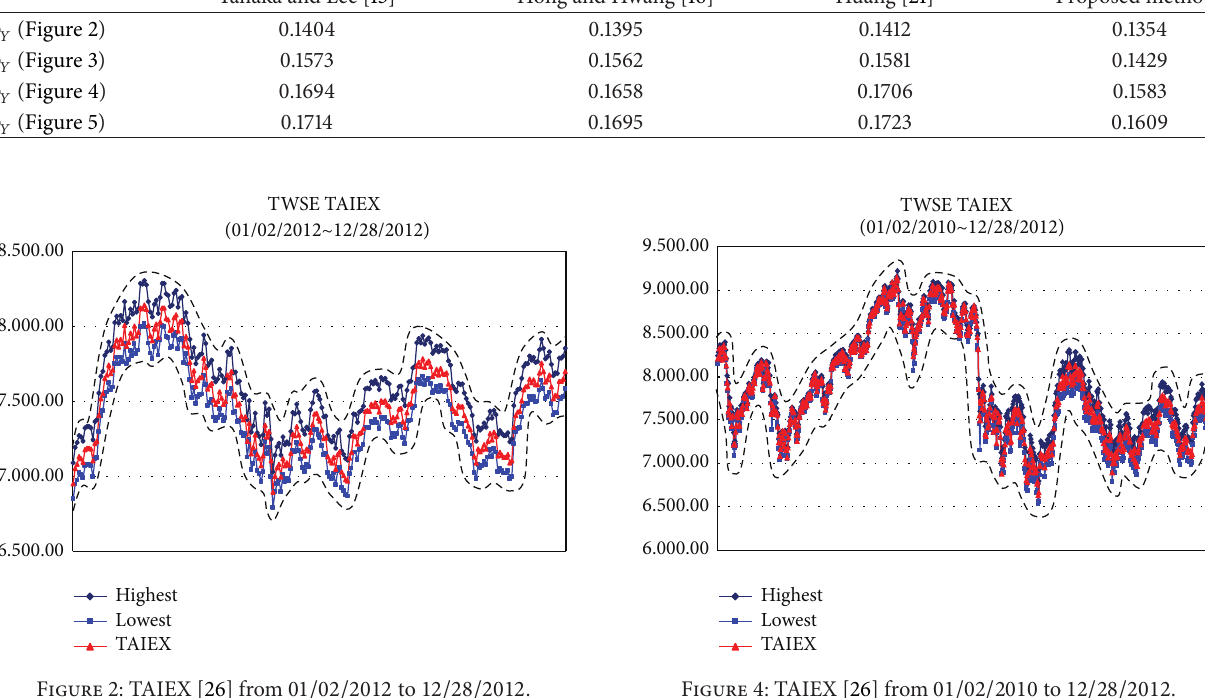
Figure 2: TAIEX [26] from 01/02/2012 to 12/28/2012 .